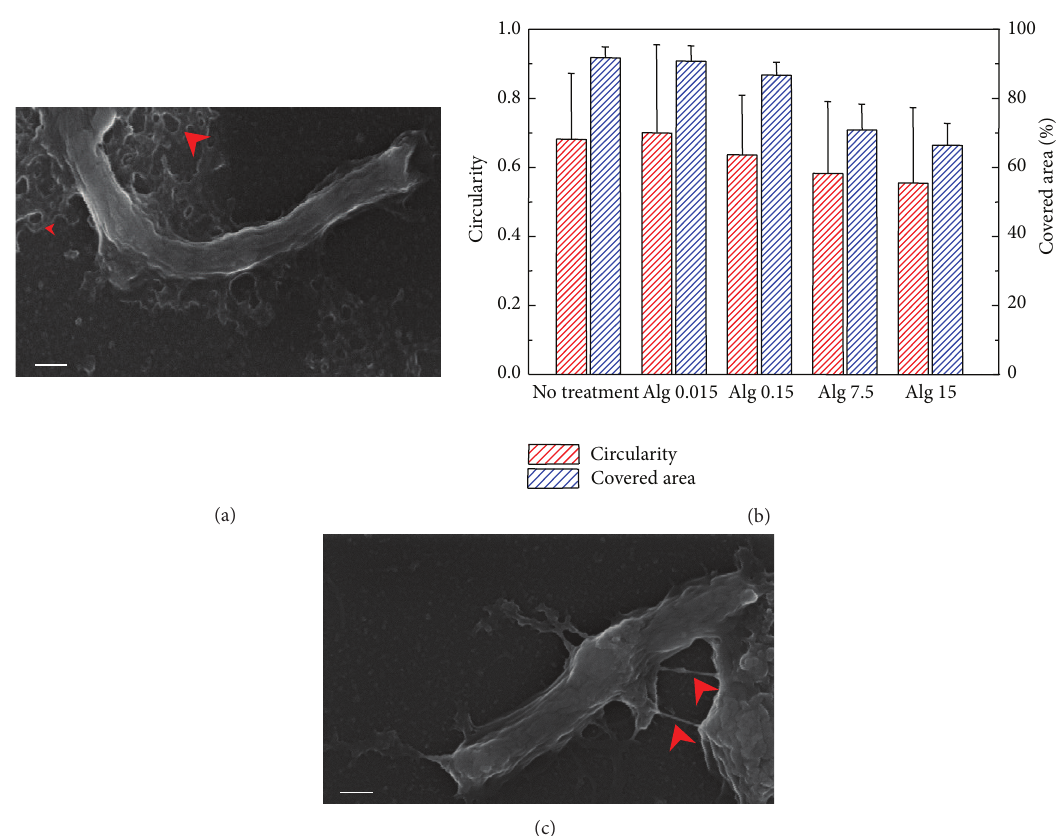
Figure 4: H. pylori circularity and percentage of surface covered by the biofilm for 5 different concentrations of AlgL (0.015, 0.15, 7.5, 15, and 39 U/mL) (b). Representative SEM images of H. pylori biofilm after the treatment with 0.15 U/mL of AlgL (a) and with 30 U/mL of AlgL. (c) Red arrows show the lysed EPS produced by the H. pylori . Scale bar 400